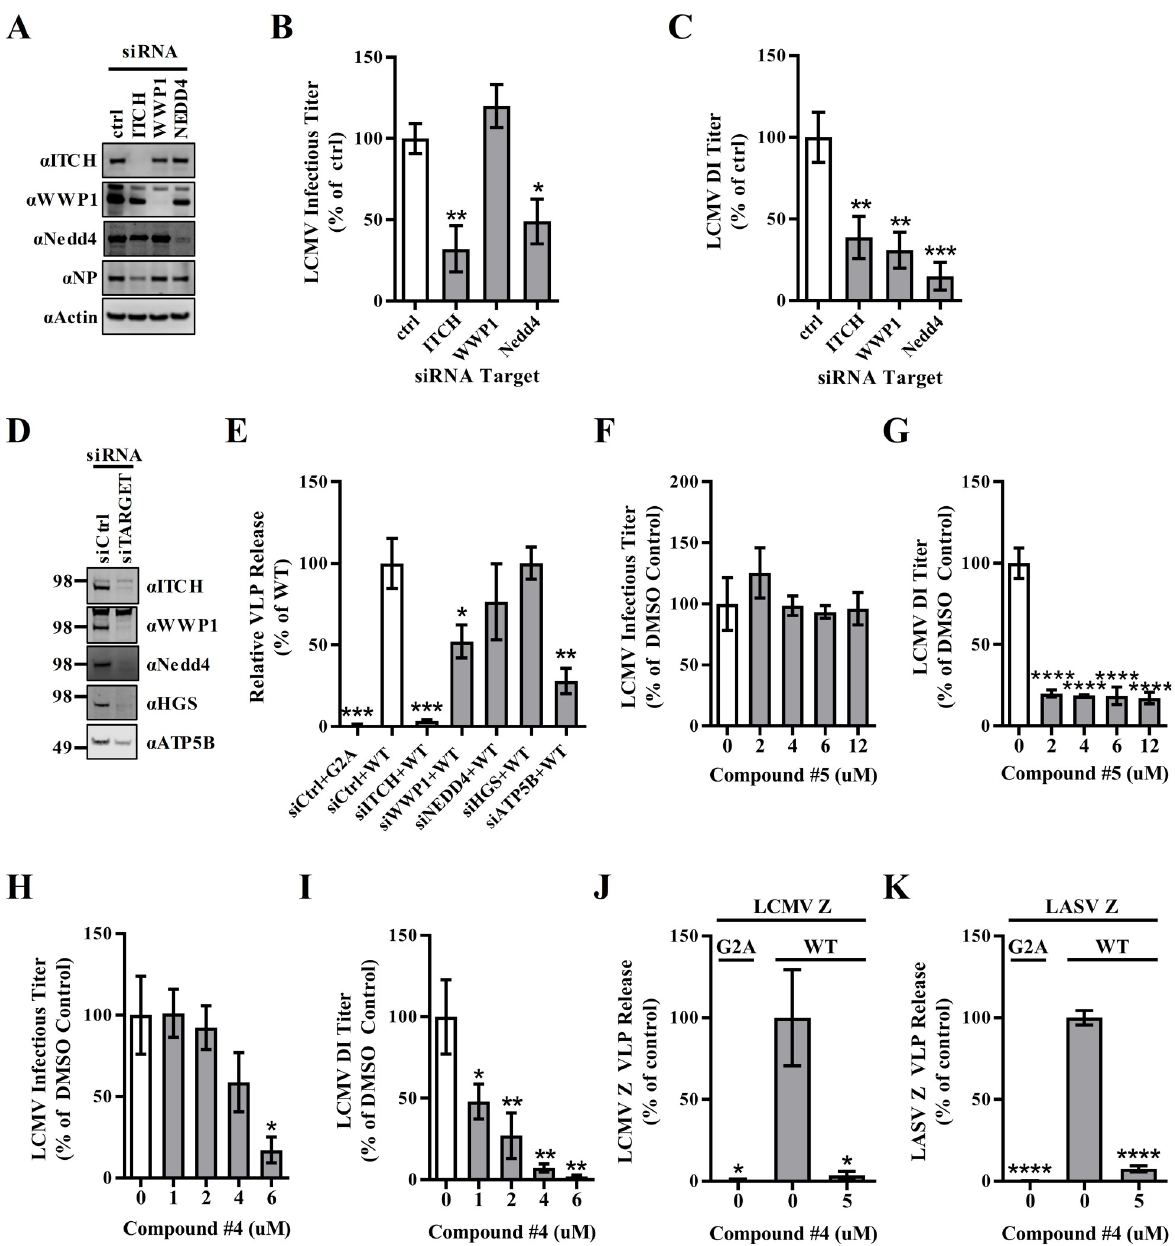
Fig 9. ITCH and WWP1 are required for virus release. (A-C) Human lung carcinoma (A549) cells were reverse transfected with small interfering (si)RNAs to the indicated targets or a non-targeting control siRNA then two days later were infected with LCMV and cells and virus-containing cell culture media were collected after an additional two days. (A) Expression of siRNA-targeted proteins, the viral nucleoprotein (NP), and actin was measured in cells by western blot. Infectious titers were determined by plaque assay (B) and LCMV DI particle titers were measured by plaque interfering assay (C). (D-E) HEK293T cells were reverse transfected with siRNAs to the indicated targets or non-targeting control siRNA then two days later were transfected with a plasmid expressing SBP-tagged WT LCMV Z. (D) Expression of siRNA-targeted proteins was measured in cells by western blot and (E) the quantity of Z in cells and VLPs was determined by quantitative western blotting from which the percent VLP release was determined. (F-I) HEK293T cells were infected with LCMV and then treated after 1 hour with compound #5 (F-G) or #4 (H-I). Infectious titers and DI particle titers were measured from the cell culture supernatant collected two days after infection. (J-K) Release of VLPs from LCMV (J) or LASV (K) Z-transfected HEK293T cells treated with compound #4 was measured by quantitative western blotting. A one-way ANOVA with Holm-Sidak’s test for multiple comparisons was used to compare the mean values to the control siRNA (B, C and E) or the DMSO control (F-K). Data in (B-C and E-K) represent the mean ± SEM from four (B-C) or three (E-K) independent experiments. � p < 0.05, �� p < 0.01, ��� p < 0.001, ���� p < 0.0001.